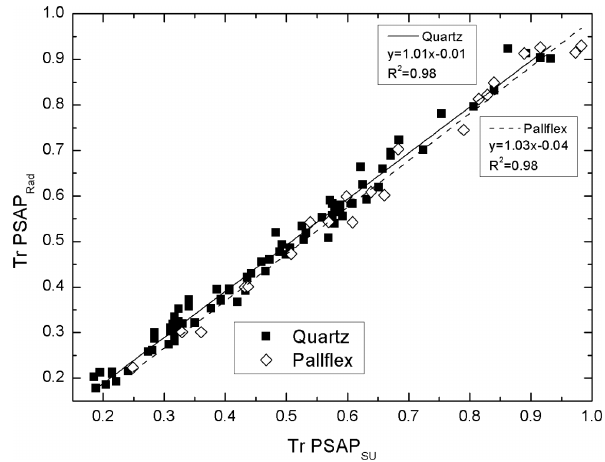
Figure 3. Transmittance for quartz and Pallflex filters measured with PSAP Radiance Research and the Stockholm University custom-built